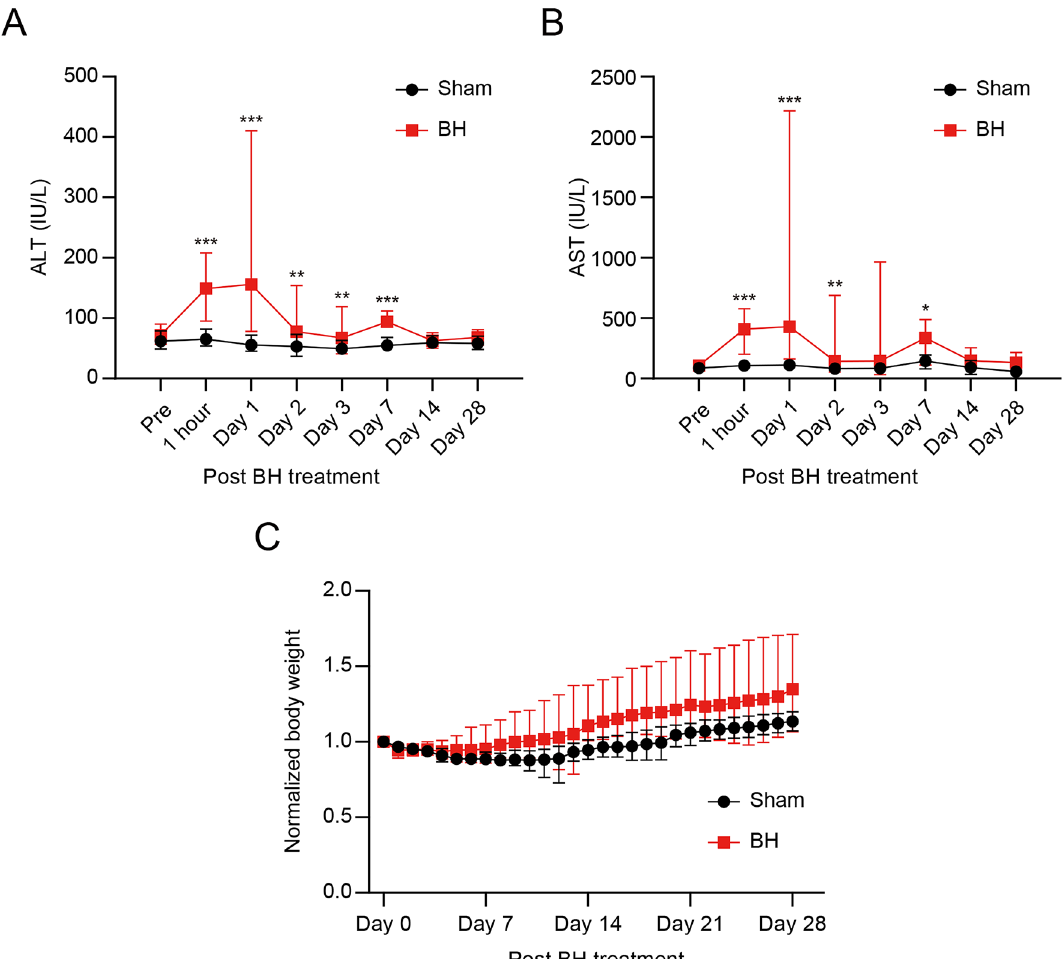
Figure 5. Recovery of surrogate markers of liver injury and body weight after BH-treatment. ( A and B ) Changes in serum AST and ALT in response to BH-treatment. Pre: prior to BH-treatment. n = 16 for Pre, n = 19 for 1 h, Day 1, 2, and 3, n = 4 for Day 7 and 14, n = 5 for Day 28. Data are presented as means ± SD. One-way ANOVA followed by a post-hoc Tukey’s test was used. *p < 0.05 , **p < 0.01 and ***p < 0.001. ( C ) Changes in normalised body weight after BH treatment. Body weights were normalised with average body weight of Day 0. n = 36 for Day 0, 1, 2, and 3, n = 29 for Day 4, 5, 6, and 7, n = 20 for Day 8 and 9, n = 18 for Day 10, 11, 12, and 13, n = 11 for Day 14, n = 9 for Day 15 to 28. Data are presented as means ± SD. One-way ANOVA followed by a post-hoc Tukey’s test was used. No significant change was